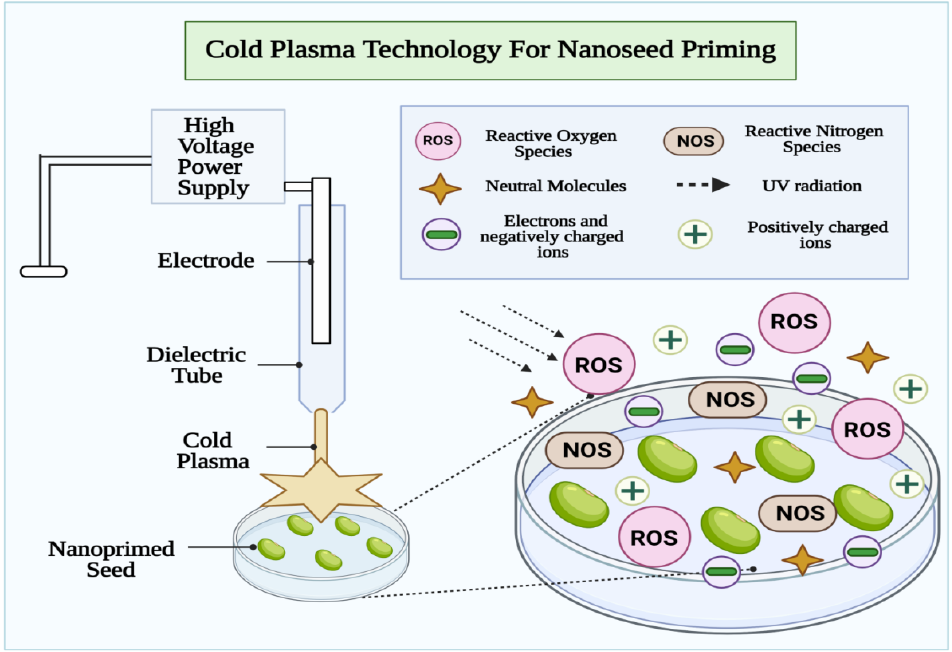
Figure 5. The cold plasma (dielectric barrier discharge) mediated seed priming improve seed vigor via synergistical activation of plant defense machinery against ROS, supporting redox homeostasis in plant. Bases on cold vs. non-thermal plasma used in seed priming, the energetic electrons, charged particle, and reactive species are produced, which dissolve tough seed coat promoting water uptake and drought yield in the crop.